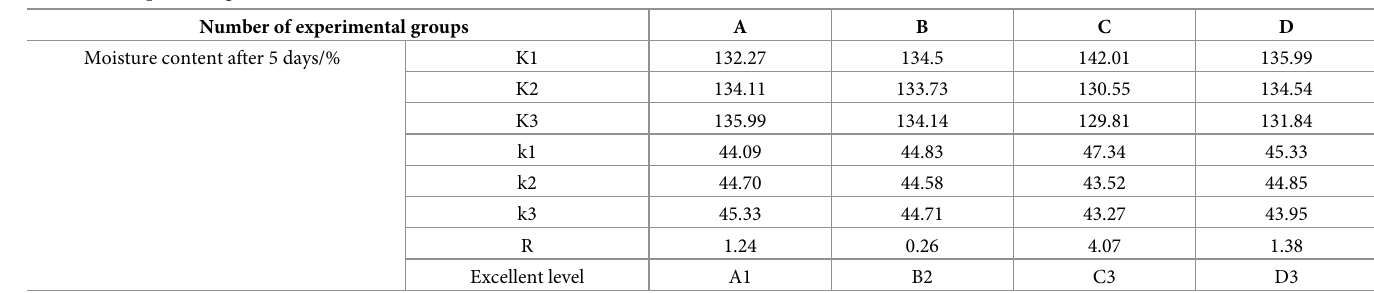
Table 4. Data processing results table.